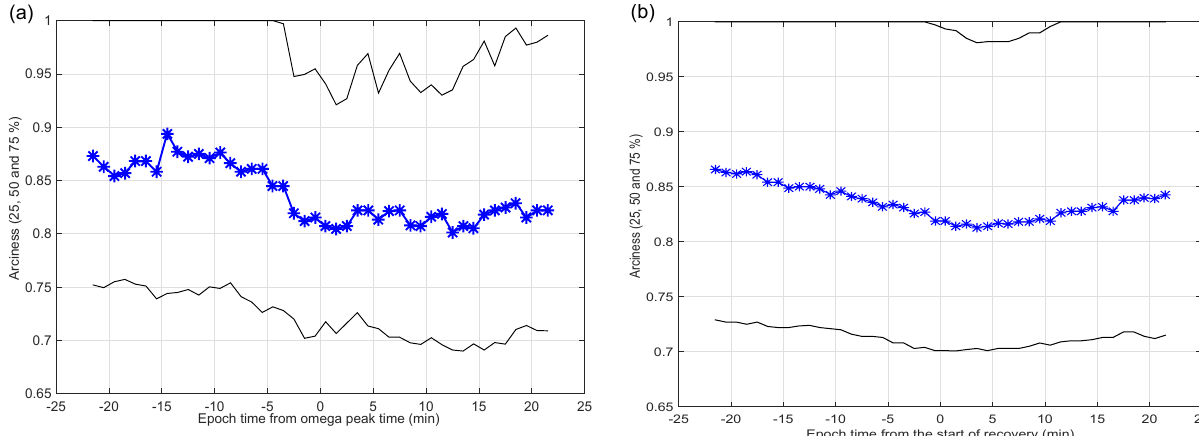
Figure 3. Median value of auroral arciness (blue curve) for ± 20min of the omega peak time for all 438 omega structures (a) , and for recovery phases (b) . The x axis is the epoch time in minutes and the zero epoch time is the peak time of omegas, and the start of the phase for the recovery phases. The number of data points (images) in each 1min time slots varies from 400 to 700 for omegas and is thousands for the recovery phases. Each omega form has been considered individually in the superposed epoch analysis. A high level of variation in the arciness is described by the quartiles (black curves) but the same mild behaviour is seen in the quartiles as well as in the